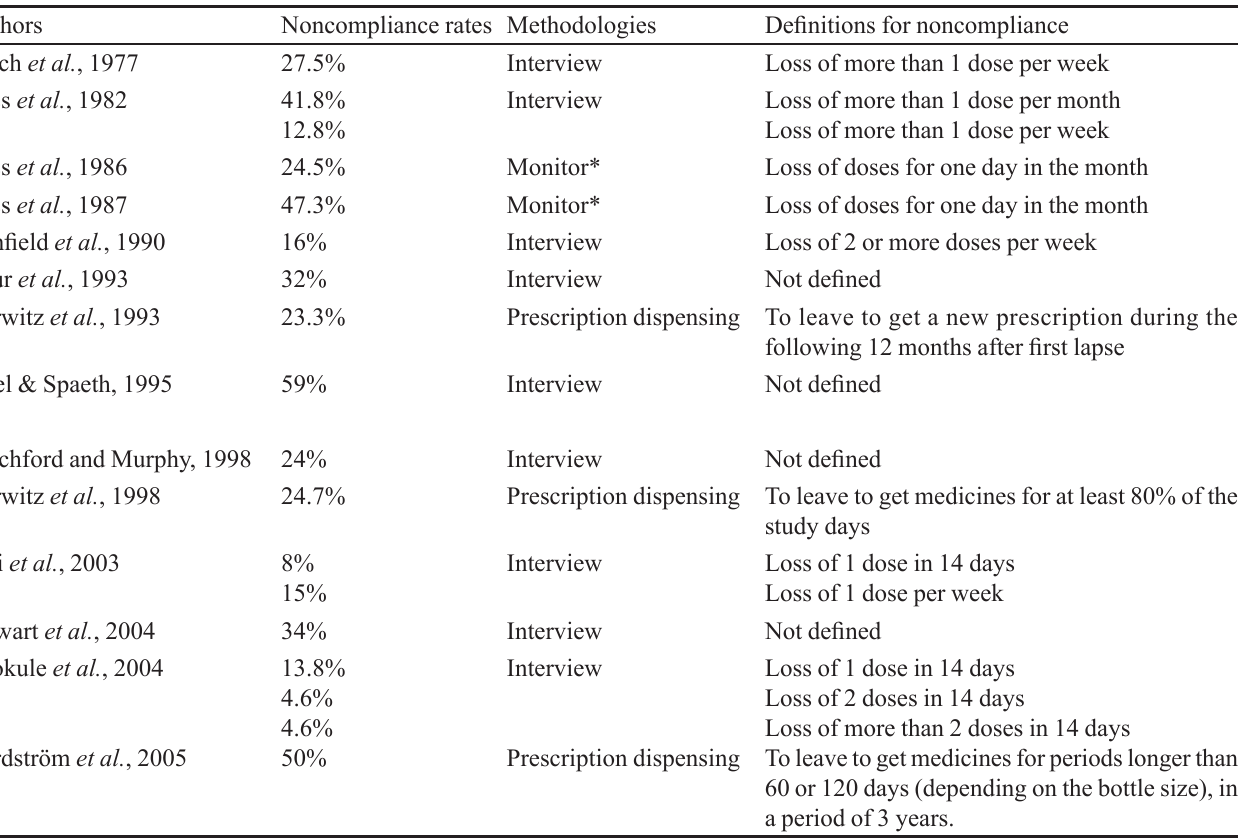
TABLE II - Rates of noncompliance to the drug